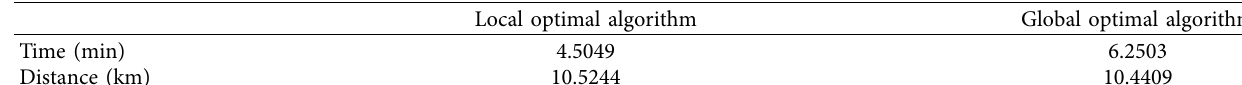
Table 7: Comparison of two algorithms.